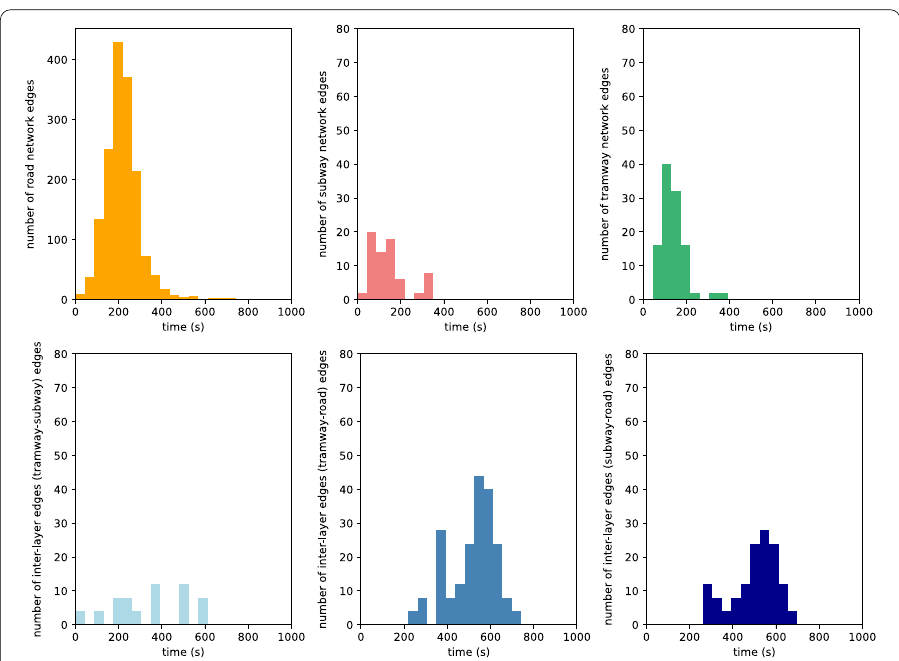
Fig. 2 Intra‑layer edge weight distributions for the road network (orange), the subway network (pink) and the tramway network (green), and inter‑layer edges weight distribution between public transport system modes (light blue), between the road network and the tramway network (blue), between the road network and the tramway network (dark